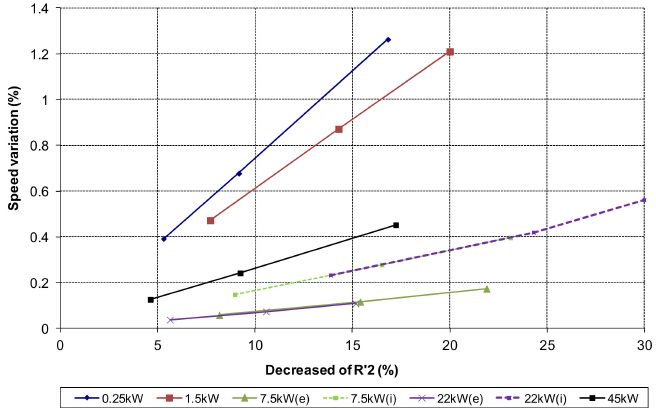
Figure 15. Speed variation versus decreased of R (cid:48) 2 in all the motors (in the double cage motors, subscript e for external cage variation and subscript i for internal cage variation is used) (equal output power criteria).